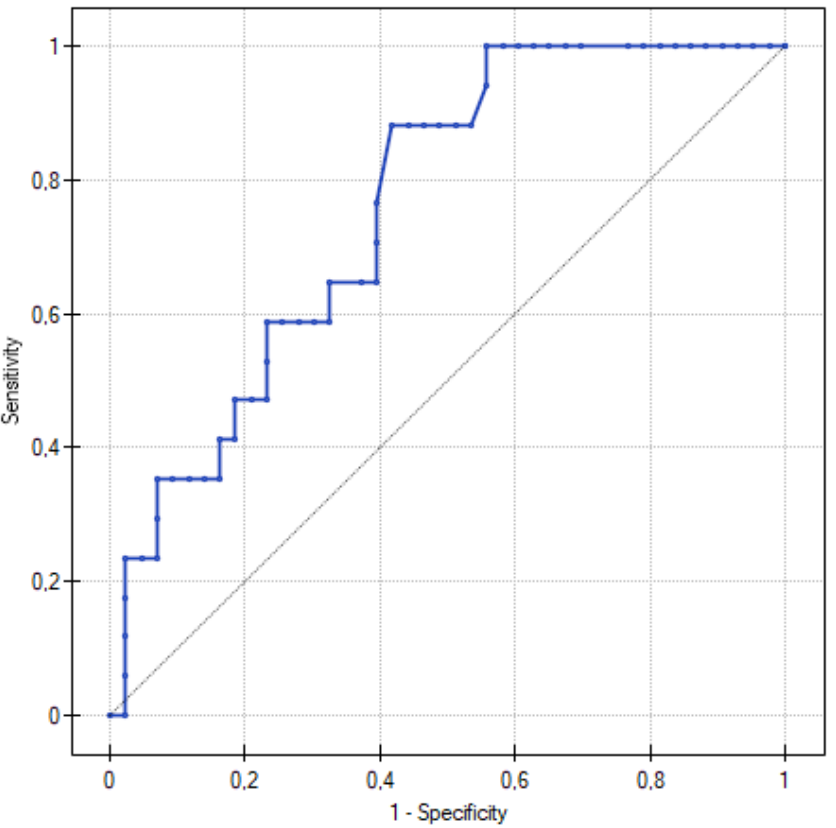
Figure 2. ROC curve for predicting preeclampsia according to corin serum levels in 20th week of gestation. At a corin cut-off value of 2.676 ng/mL, the sensitivity was 88.24% and the specificity was 58.14%, with an AUC = 0.760 (95% CI, 0.637–0.883).